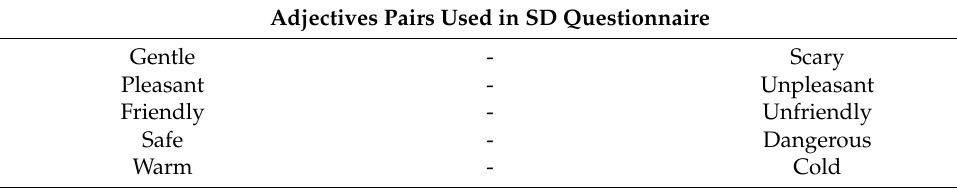
Table 5. Adjectives pairs used in the SD questionnaire